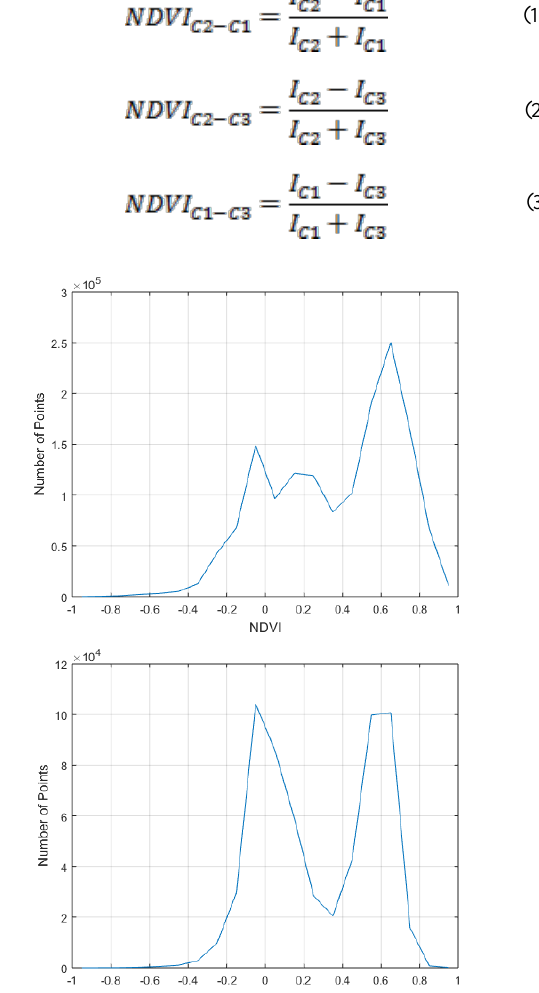
Figure 4. NDVI C2-C3 histograms constructed from non-ground points (upper) and ground points